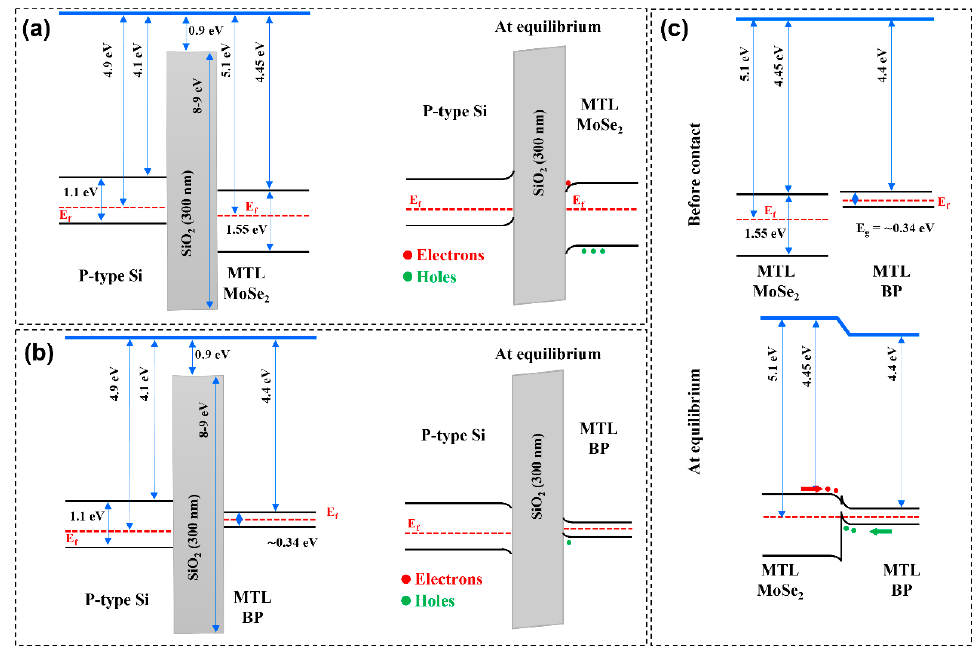
Figure 2. Energy band diagram of multilayered ( a ) n-MoSe 2 and ( b ) p-BP before and after contact in the vertical direction and that of ( c ) n-MoSe 2 /p-BP before and after contact.